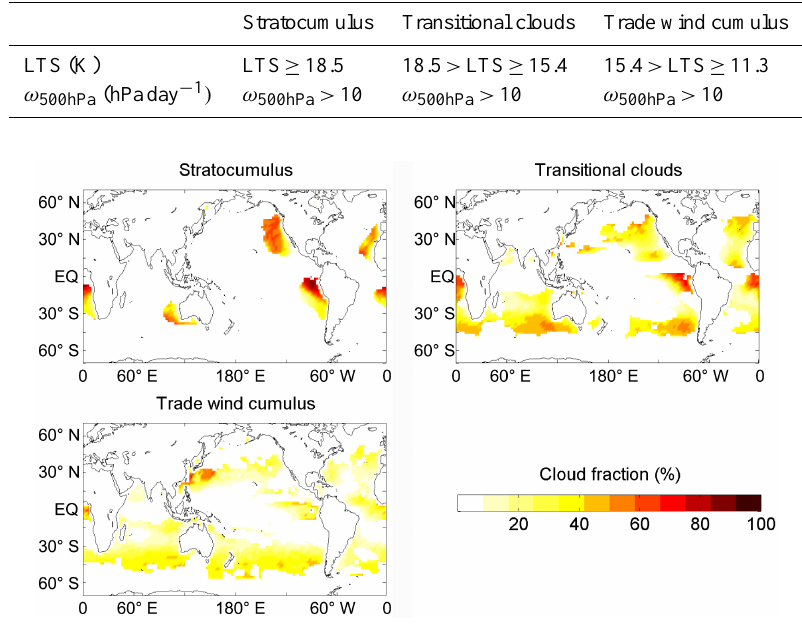
Figure 4. The annual mean cloud fraction (averaged on the months when the regime occurs) of stratocumulus regime (top left), transi- tional clouds regime (top right) and trade wind cumulus regime (bottom left) derived from PD monthly simulation in CAM5-CLUBB. The definitions of different cloud types are listed in Table